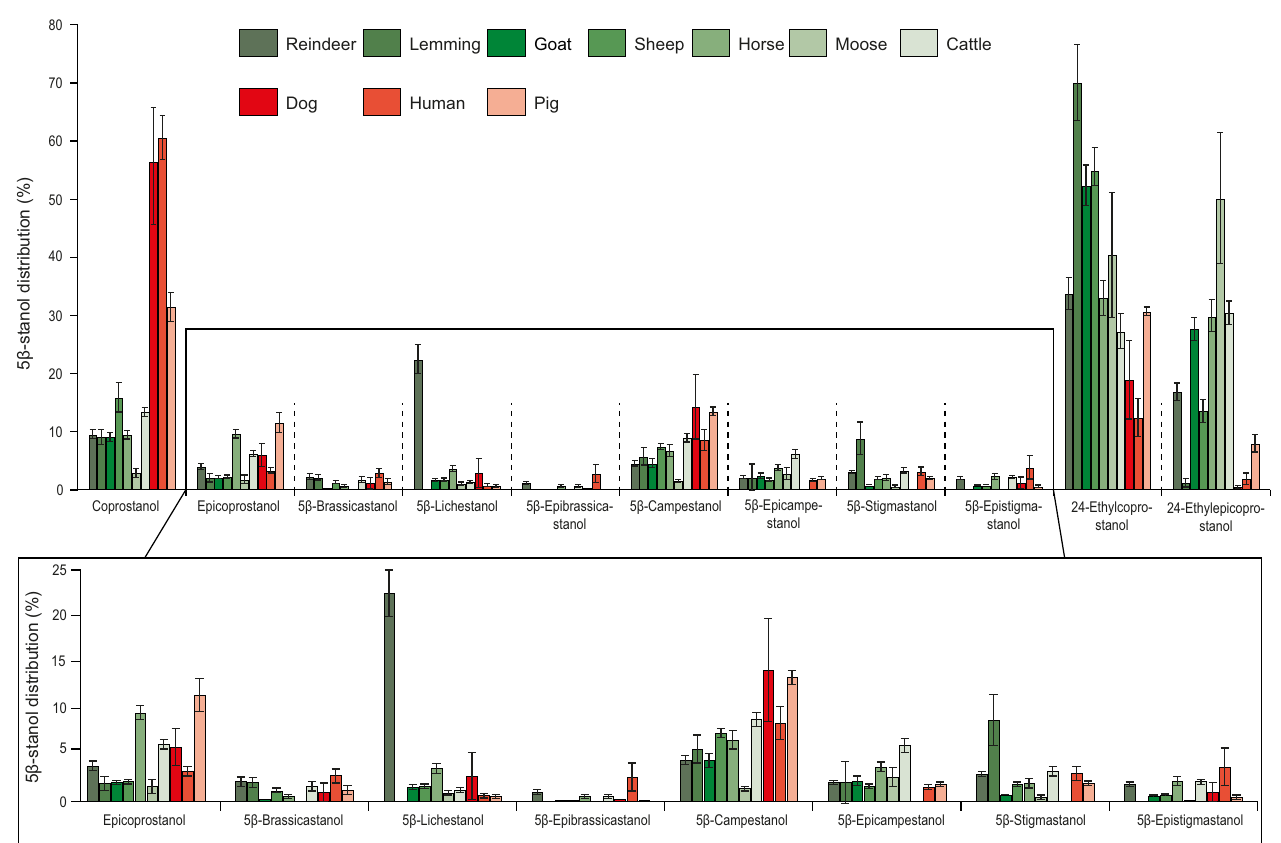
Fig 1. Distributions of 5 β -stanols in herbivore and omnivore faecal material. Compound information can be found in S1 Table and S2 Fig. Mean ± SE. Individuals: n(reindeer) = 23, n(lemming) = 6, n(goat) = 9, n(sheep) = 12, n(horse) = 7, n(moose) = 5, n(cattle) = 9, n(dog) = 4, n(human) = 8, n(pig) = 7. Individual sample information and 5 β -stanol distributions can be found in S2 Table.